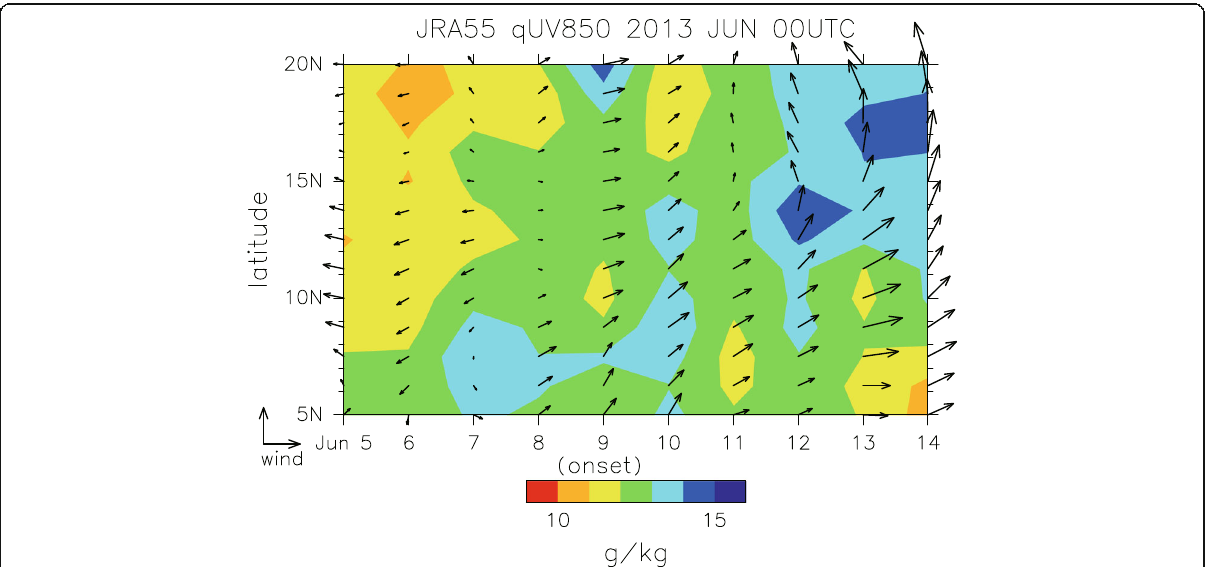
Fig. 11 Cross section (5° N 20° N, 115° E 120° E) of water vapor mixing ratio (shading; g/kg) and wind (vector) at 850 hPa during June 5 – 14, 2013.